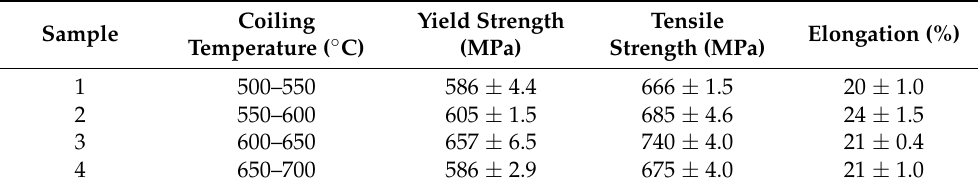
Table 2. Mechanical properties obtained from tensile